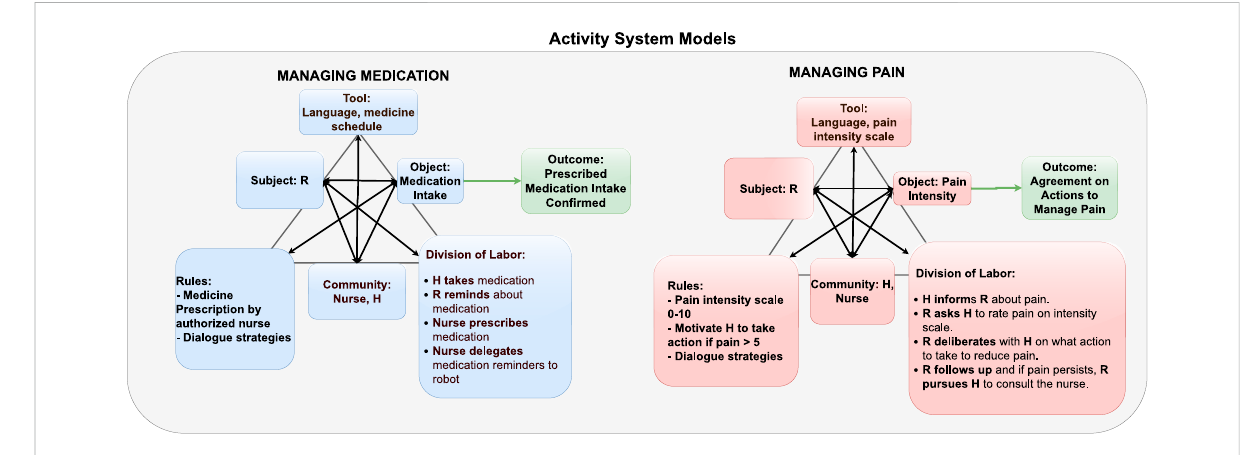
FIGURE 1 Example of activity system models interpreted using the Engeström ’ s model for the activities managing medications and managing pain. The activity systems provide a template for instantiating the activity, including the knowledge required about actors, objects, rules, community, tools,